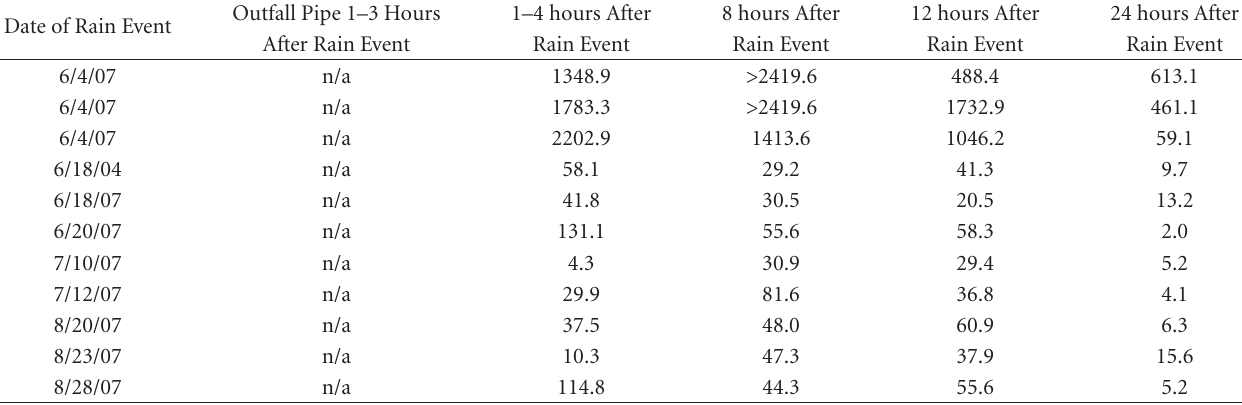
Table 4: E. coli concentrations ( ∗ MPN/100mL) from beach water collected at time intervals following the triggering of a rain event at Ellison Bay beach. Using Sche ff e matrix analysis, E. coli concentrations measured in the first four hours after the rain event was triggered were significantly di ff erent from the seasonal mean E. coli concentration for this beach ( P < . 001). Likewise, E. coli concentrations measured at 8 hours or 12 hours after the rain event was triggered were significantly di ff erent from the seasonal mean E. coli concentration for this beach ( P < . 001 and P < . 002, resp.). If rainfall was su ffi cient to trigger multiple rain event notifications on one day, then multiple events were sampled.